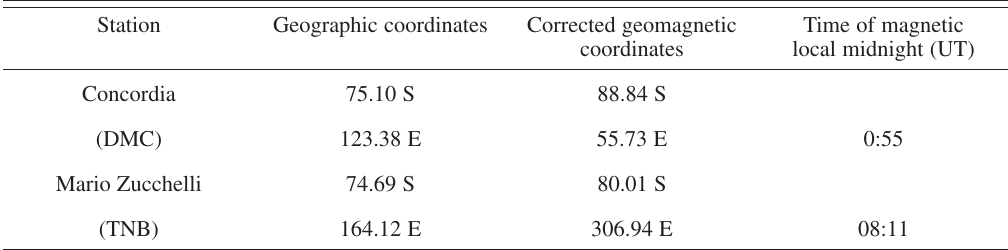
Table I. Coordinates of the recording